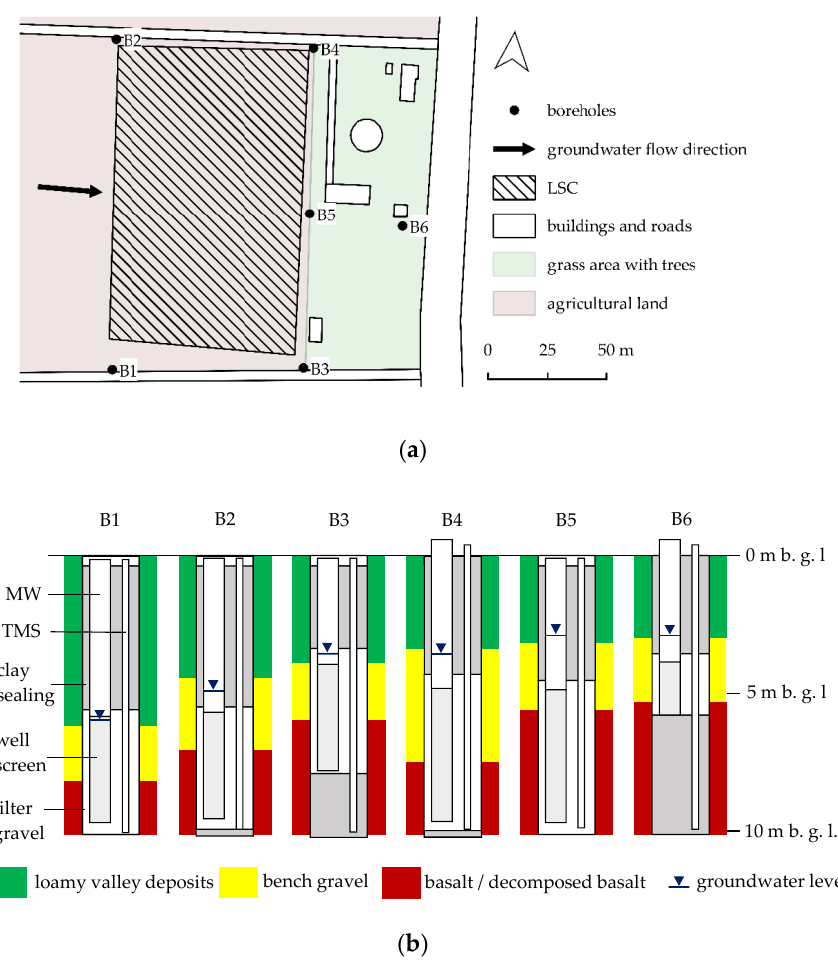
Figure 1. ( a ) Large-scale geothermal collector system (LSC) and positioning of six boreholes around the LSC site; ( b ) each borehole contains a groundwater monitoring well (MW) and a temperature measuring station (TMS). Additionally shown are the well casings, the borehole filling, the boundaries of the geological units in metres below ground level (m b. g. l) and the mean groundwater level in each borehole. For ease of representation, the overlying soils have been combined with the loamy valley deposits. In the deepest section of each borehole, the drill diameter was reduced from 220 mm to 178 mm, which is not shown in the figure.